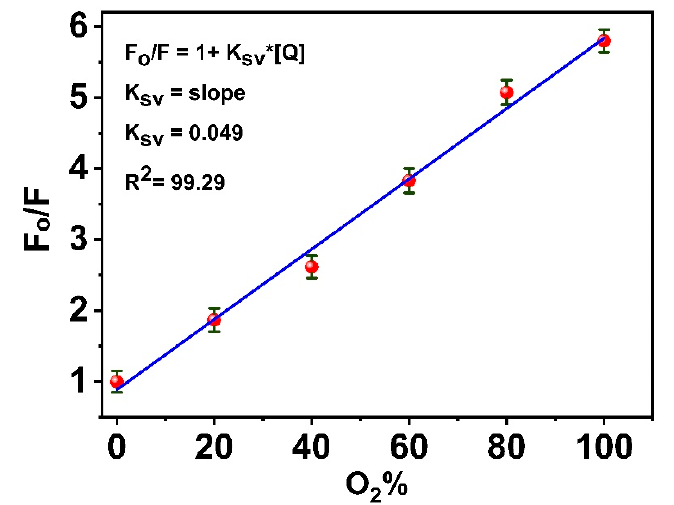
Figure 11. Stern–Volmer plot for the oxygen nanosensor for oxygen concentration in the 0–100% range.